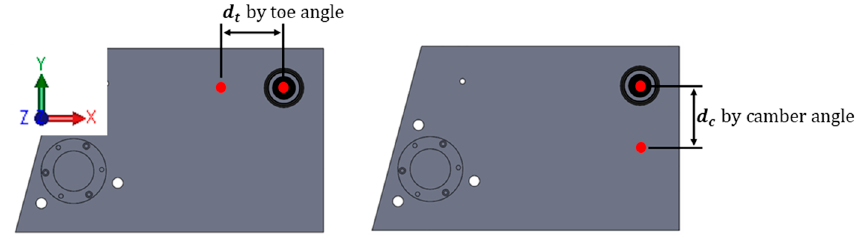
Figure 8. Direction of laser mark by toe and camber angles.